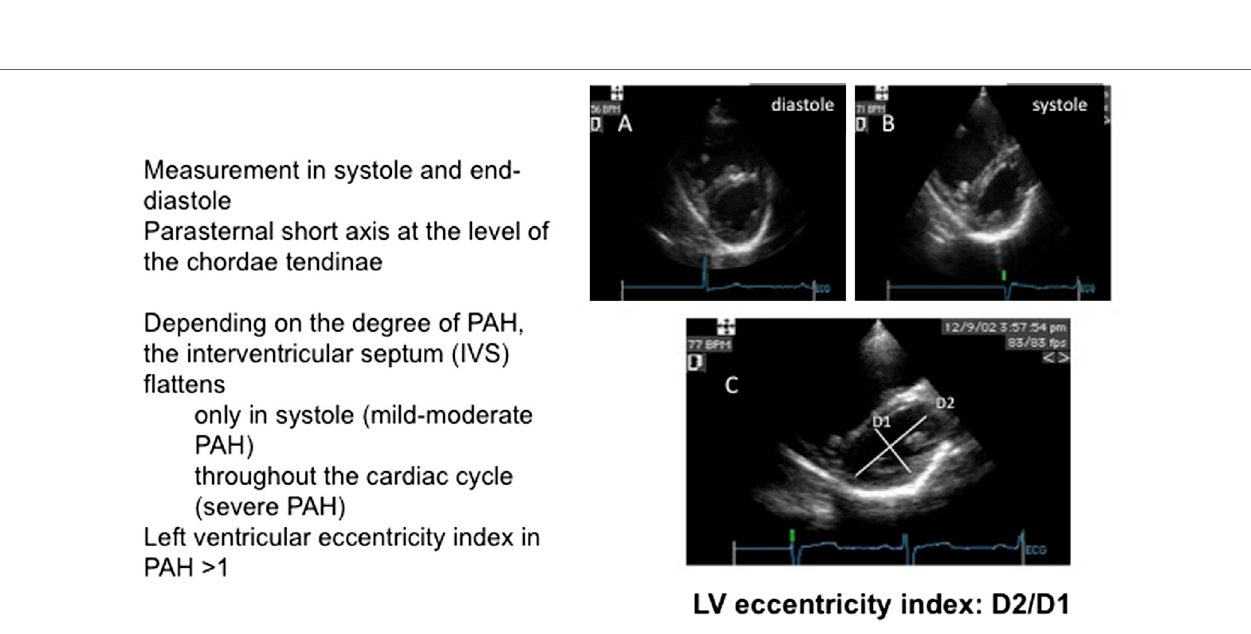
FigURe 5 | Assessment of the interventricular septal curvature. (A) Short axis view in diastole. (b) Short axis in systole. (C) Measurement of the LV eccentricity index.